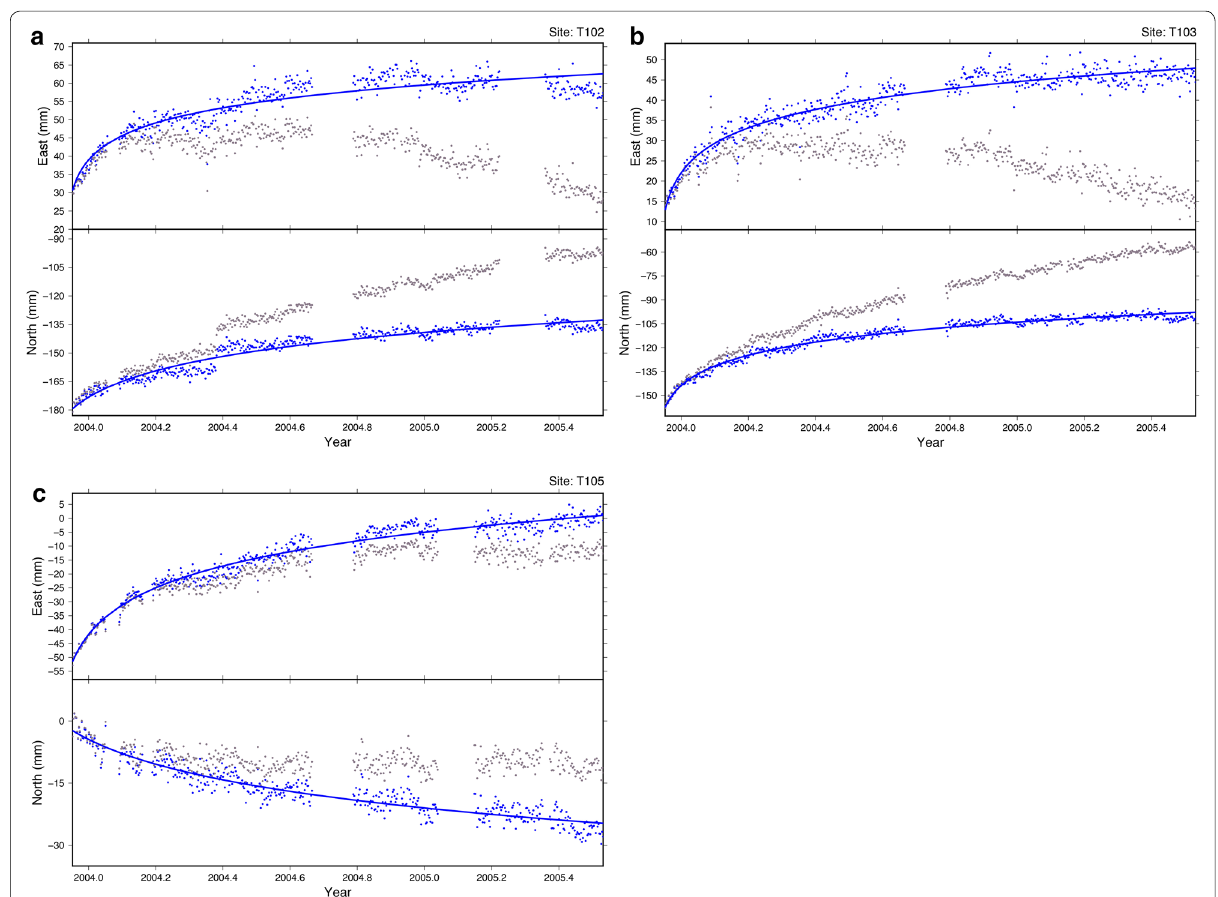
Fig. 4 Postseismic time series fitting for stations a T102, b T103 and c T105. Grey dots are original GPS time series, and blue dots are postseismic signals only with interseismic velocities removed. Blue lines are postseismic fitting using the logarithmic